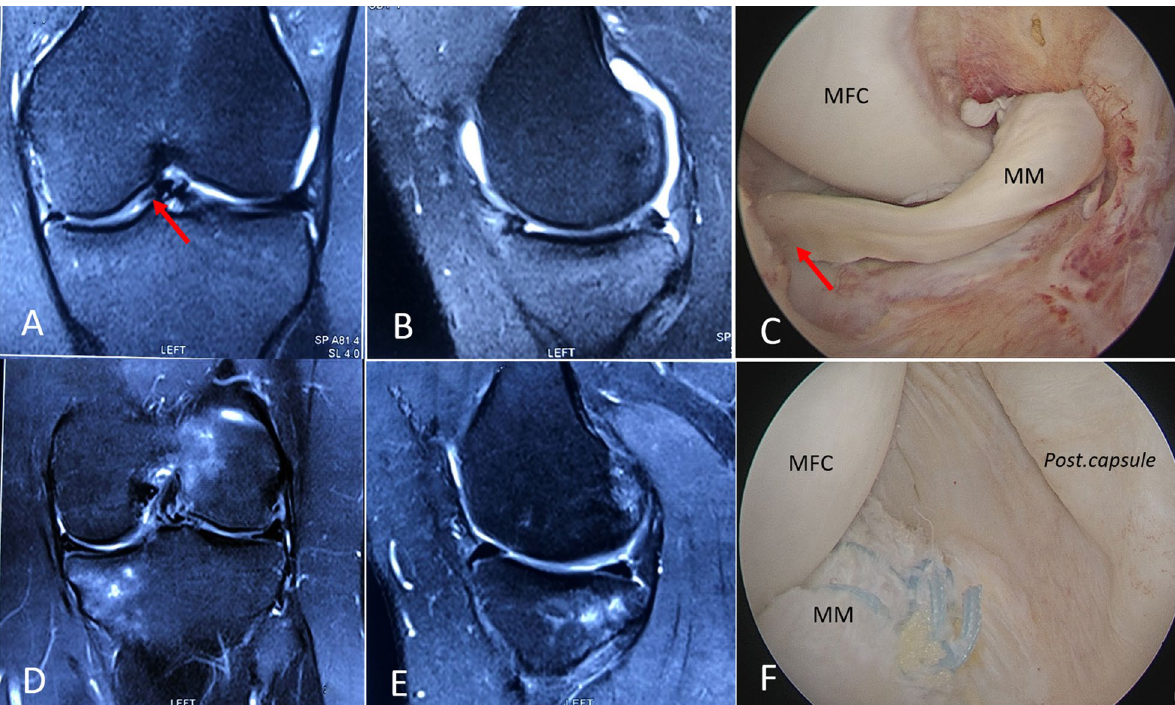
Fig. 4 Preoperative T2-sequenced coronal ( A ) and sagittal ( B ) MR images of an unstable chronic BHMMT ( arrow ). C Rotation ( arrow ) is visible in an anterolateral portal view of the left knee. Postoperative coronal ( D ) and sagittal ( E ) MR images show healing after 6 months. Posterolateral trans-septal view ( F ) after meniscal repair shows anatomical reduction. MR magnetic resonance, MFC medial femoral condyle, MM medial meniscus